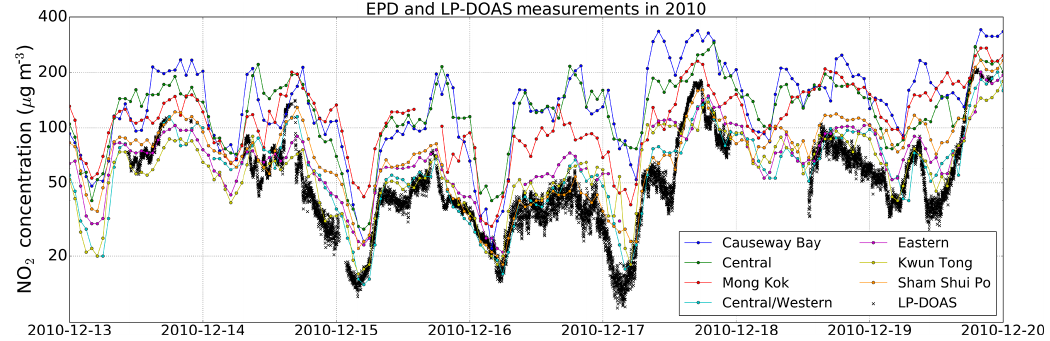
Figure 3. Time series of NO 2 concentration measured by LP-DOAS and EPD monitoring stations during the measurement campaign in 2010.